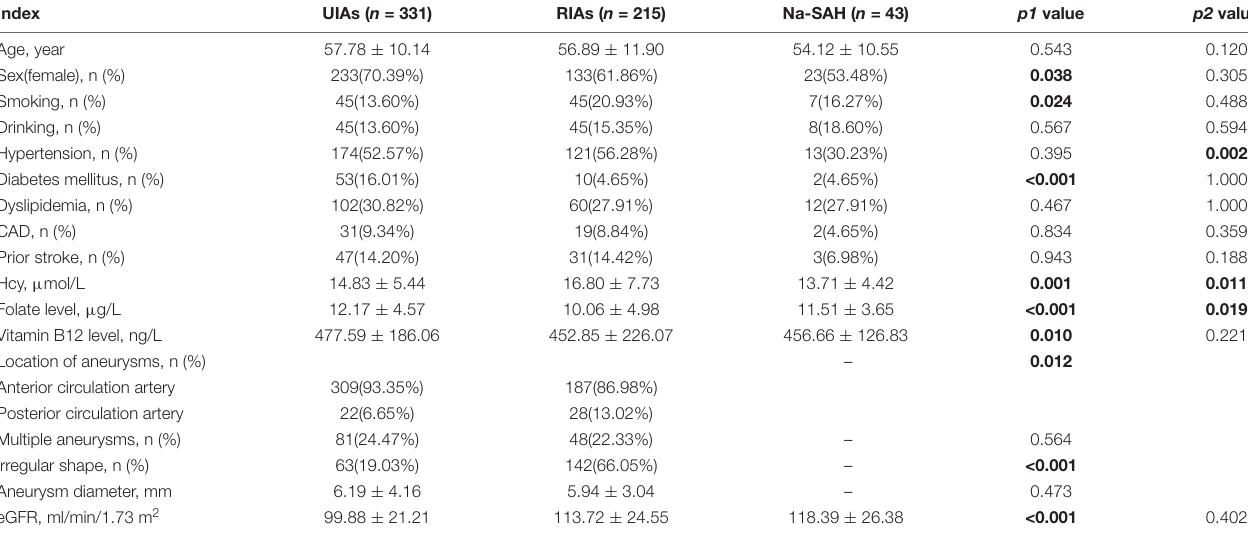
TABLE 1 | Demographic and clinical characteristics of patients with intracranial aneurysms and subarachnoid